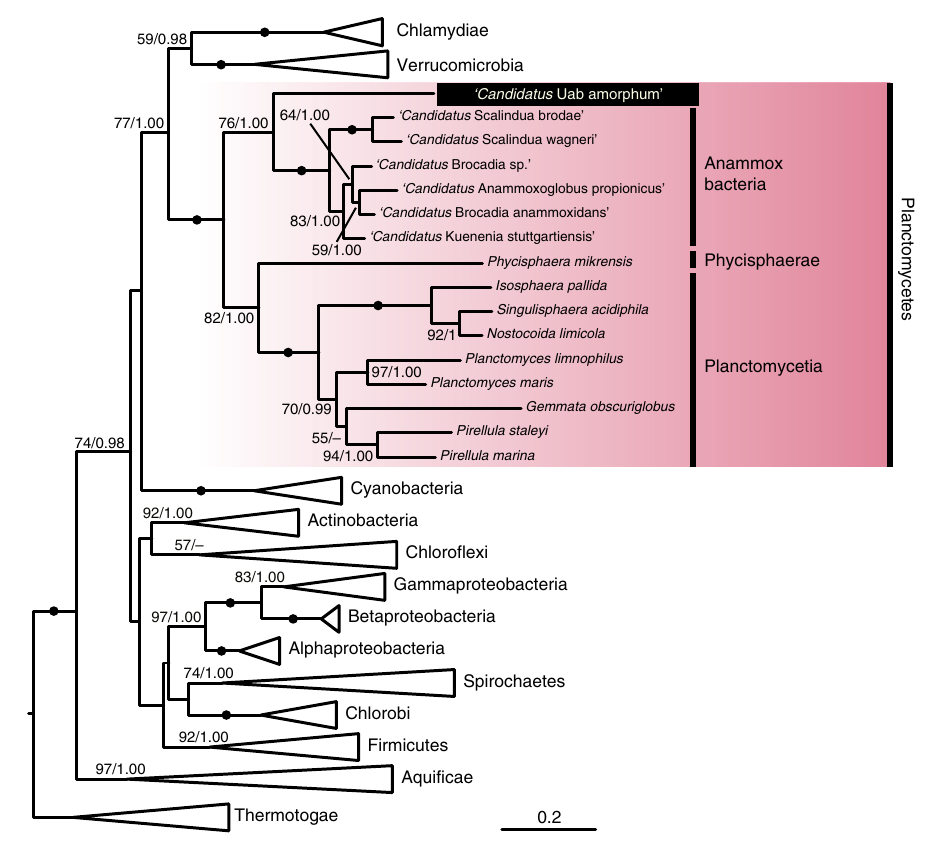
Fig. 2 Maximum likelihood tree of ‘ Ca . Uab amorphum ’ and other bacterial 16S rRNA gene sequences. Left and right values on nodes indicate bootstrap value and Bayesian posterior probability, respectively. Scale bar indicates nucleotide substitution rate per